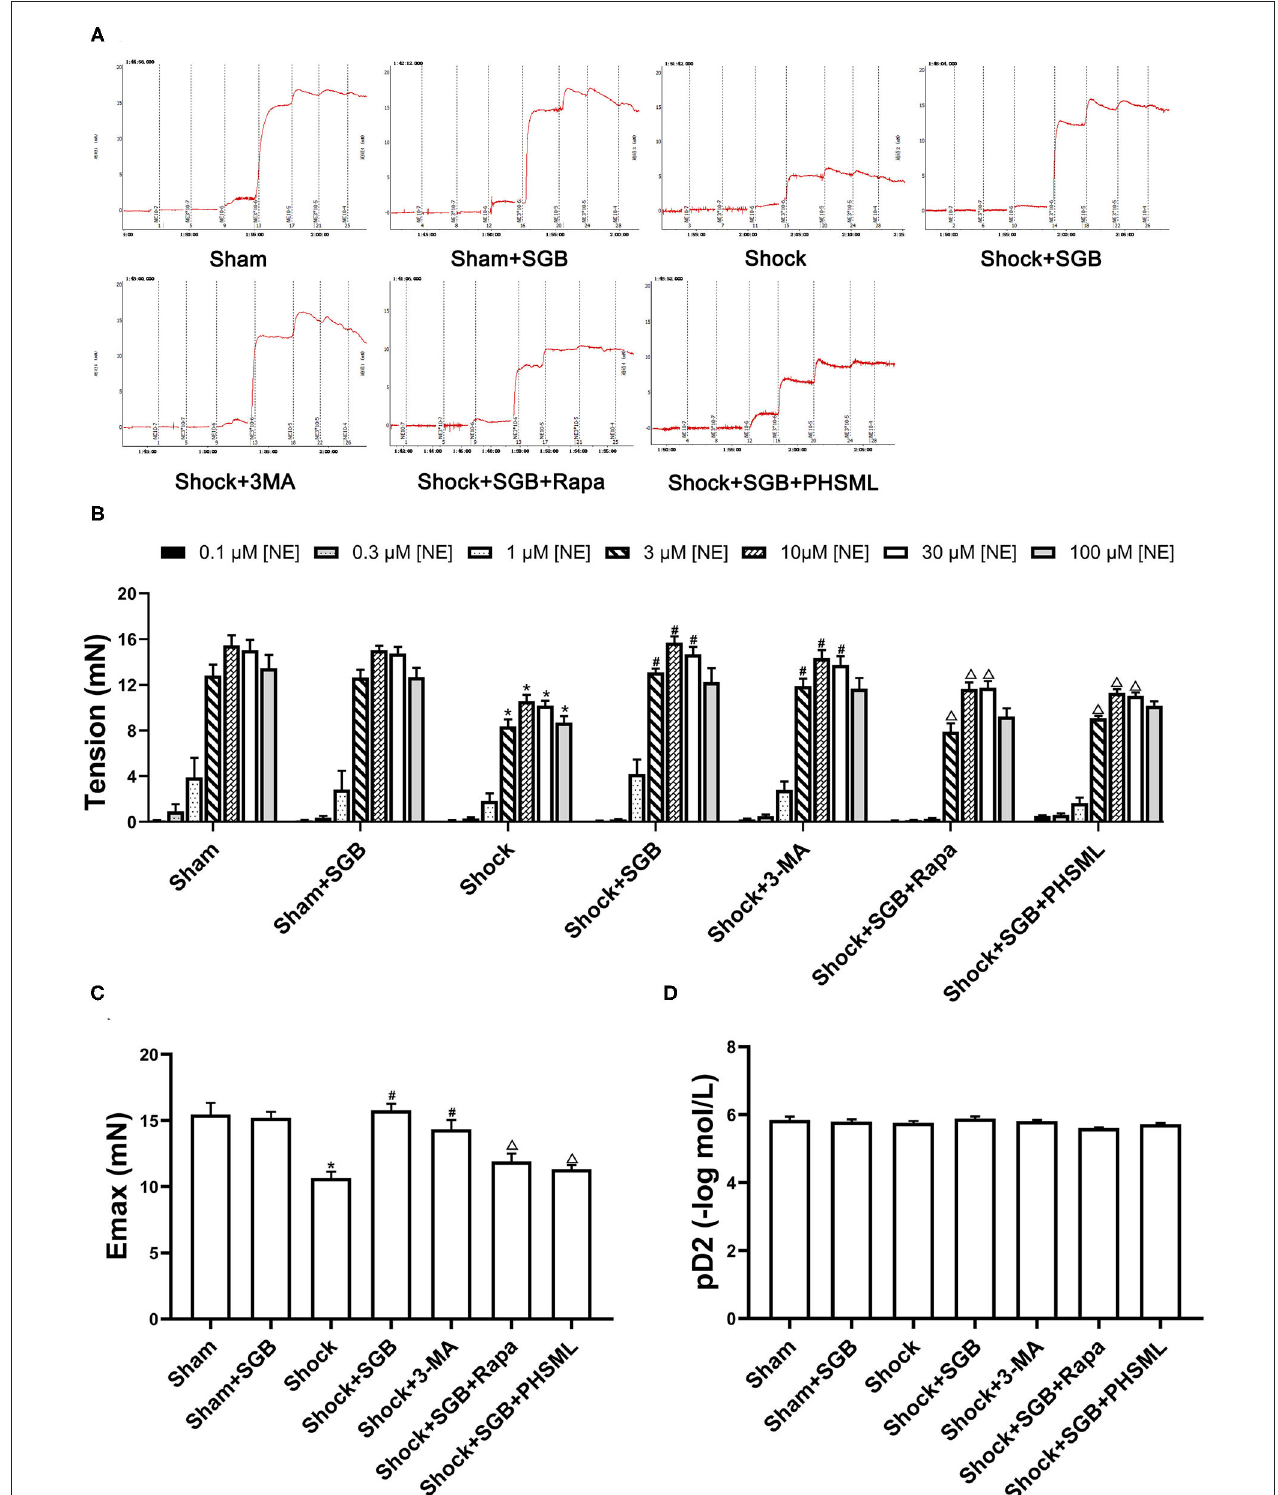
FIGURE 2 | Effect of stellate ganglion block (SGB) treatment, autophagy inhibitor or activator administrations, and posthemorrhagic shock mesenteric lymph (PHSML) intravenous infusion on the mesenteric microvascular contractile reactivity to norepinephrine (NE) following hemorrhagic shock. SGB was performed with 0.2ml of 0.25% ropivacaine hydrochloride hydrate; 3-methyladenine (3-MA, autophagy inhibitor) and rapamycin (Rapa, autophagy activator) administrations were performed